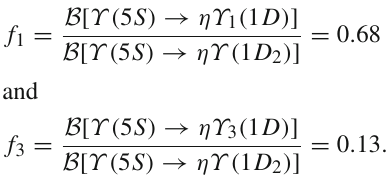
transition Υ ( 4 S ) → ηΥ ( 1 S ) with a branching fraction of ( 1 . 96 ± 0 . 28 ) × 10 − 4 , 2 . 41 ± 0 . 42 larger than the one for the favoured transition Υ ( 4 S ) → ππΥ ( 1 S ) [22]. A recent Belle